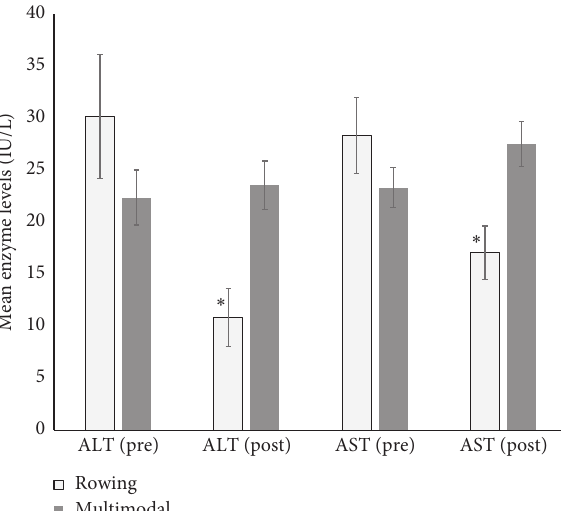
Figure 1: Unadjusted preintervention and adjusted postintervention ALT and AST mean values in rowing and multimodal groups with standard error. ∗ Significant change from before to after the intervention. ALT: alanine aminotransferase. AST: aspartate aminotransferase. Table 3: Summary of changes in psychosocial variables over time between R-HIIT ( n � 7) and MM-HIIT ( n � 9) groups from ANCOVA. Outcome and